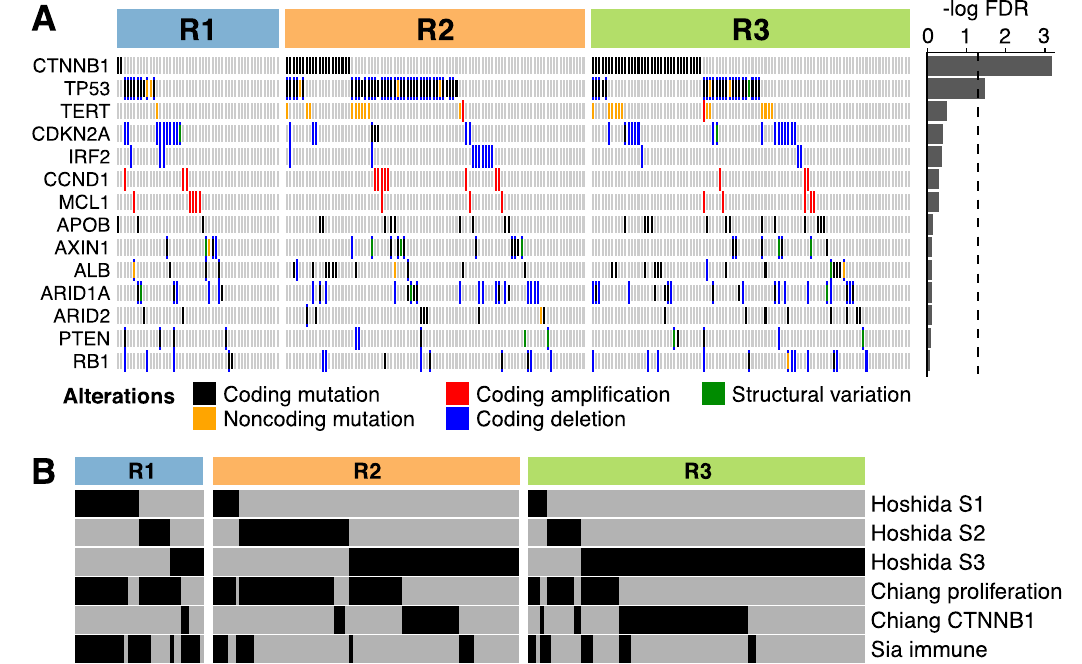
Fig. 4 | Genomic and transcriptomic features of the proteomic subclasses. A Somaticdriveralterationsinthe proteomicsubclasses.Genesthatweremutated in more than 10 tumors are shown. Bar chart on the right side shows strength of associations between alterations and subclasses, as measured by − log(FDR). FDR